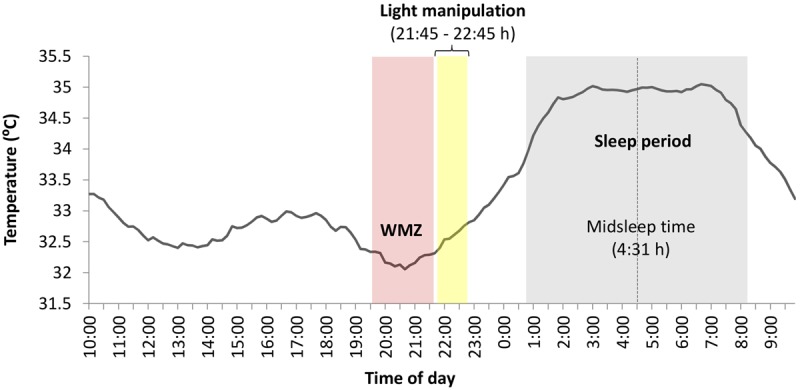
Circadian rhythm of wrist temperature averaged across participants during the week prior to the experimental session. The wake maintenance zone (WMZ, shaded in pink color), with midpoint at 20:40 h, was characterized by a dip in distal temperature values. The lighting manipulation took place an hour later, at the beginning of the distal temperature rise anticipating sleep and closely overlapping the DLMO.